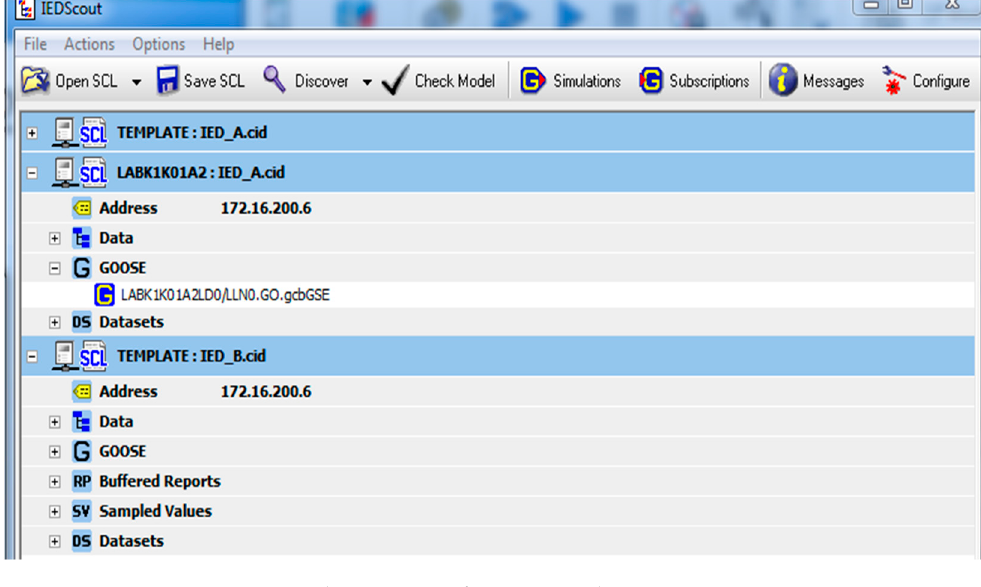
Figure 15. The structure of IED SCL and GOOSE mapping.